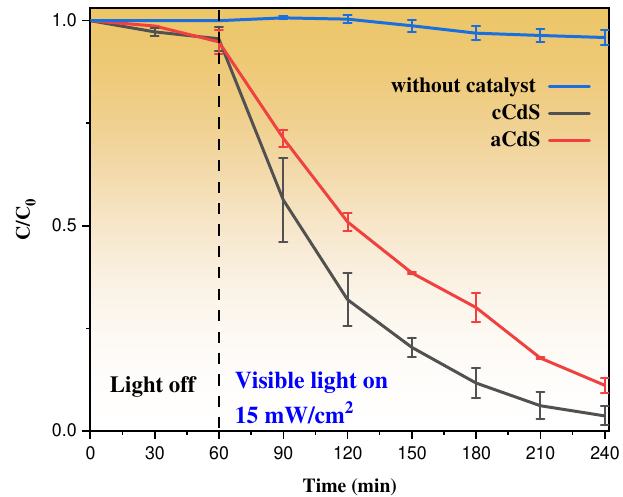
Figure 10. Photocatalytic degradation profiles of mechanochemically synthesized aCdS and cCdS catalysts under visible light irradiation.